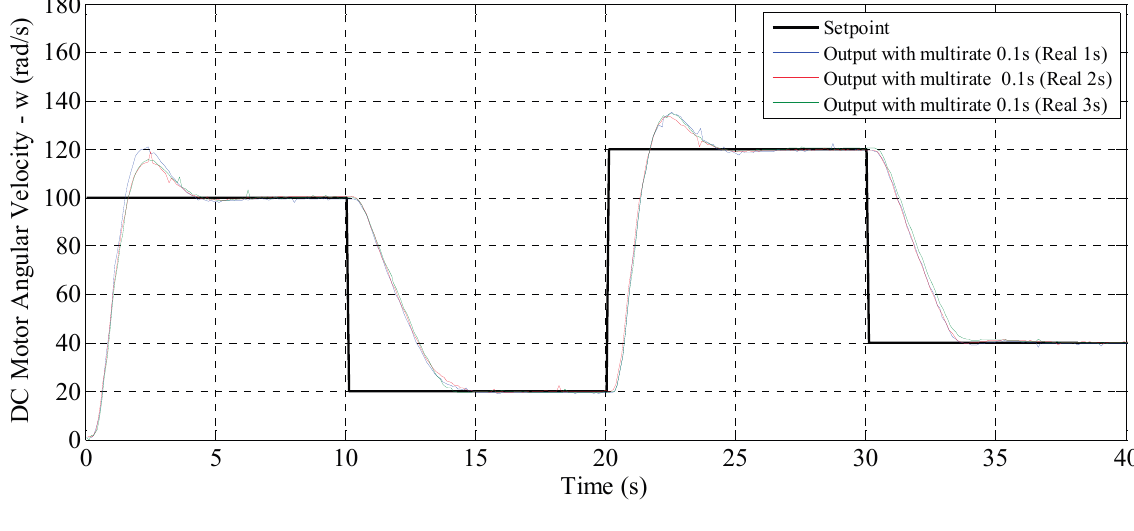
Figure 8. Comparison of control outputs of the WNCS for different sampling periods of the wireless sensor: soft sensor with multi-rate of 0.1